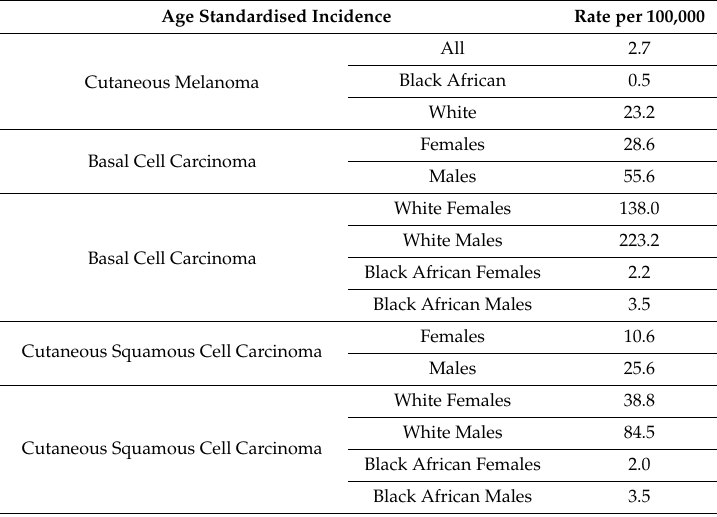
Table 1. Skin cancer statistics for South Africa for the year 2014 from NCR [11].